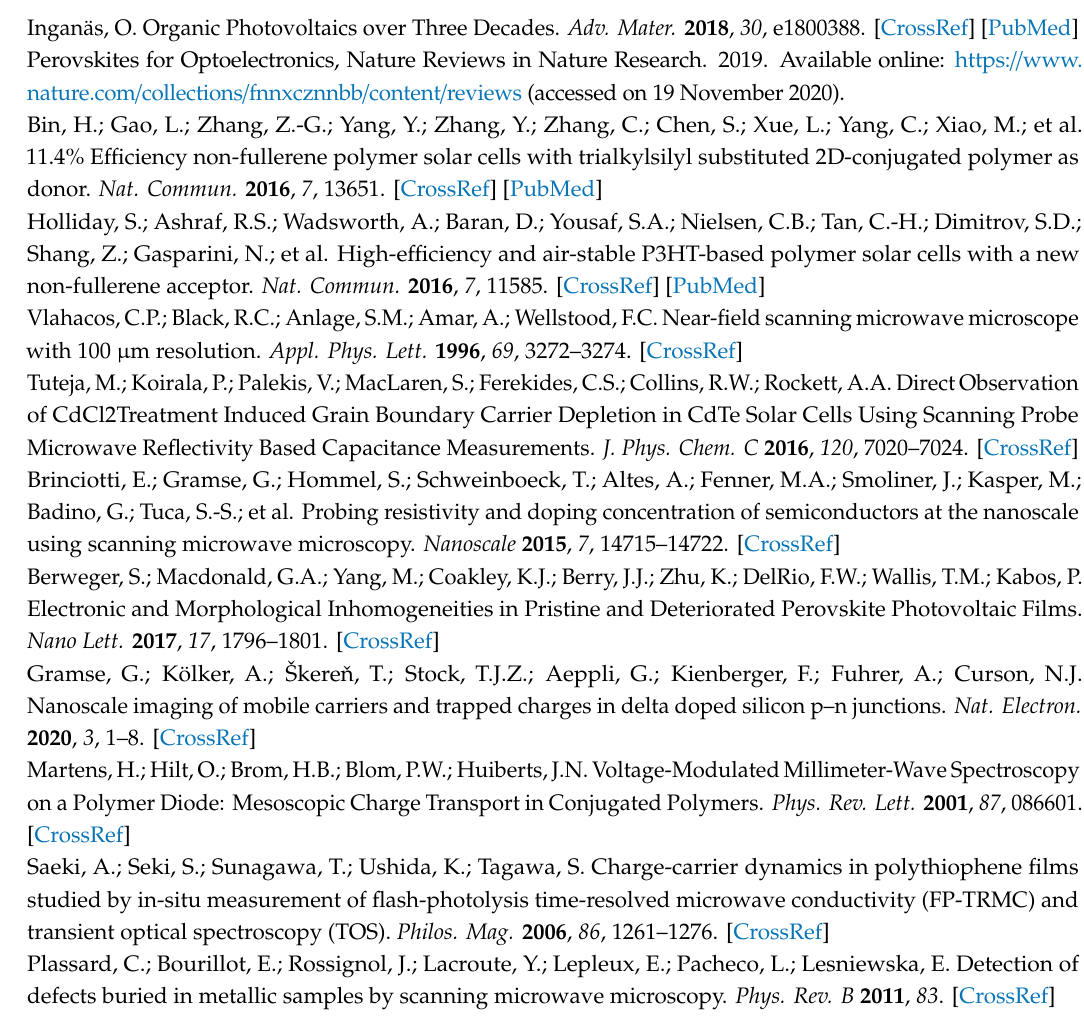
Figure S1: Complement to interferometric profiles of Figure 2, Figure S2: Complement to interferometric and time profiles of Figure 2, Figure S3: additional interferometric and associated time profiles at 10.46944 GHz, Figure S4: Schematic of the variations of the tip sample interactions varying microwave frequency and probed bias, Figure S5: interferometric and associated time profiles at 3.5709 GHz, S6: Interferometer